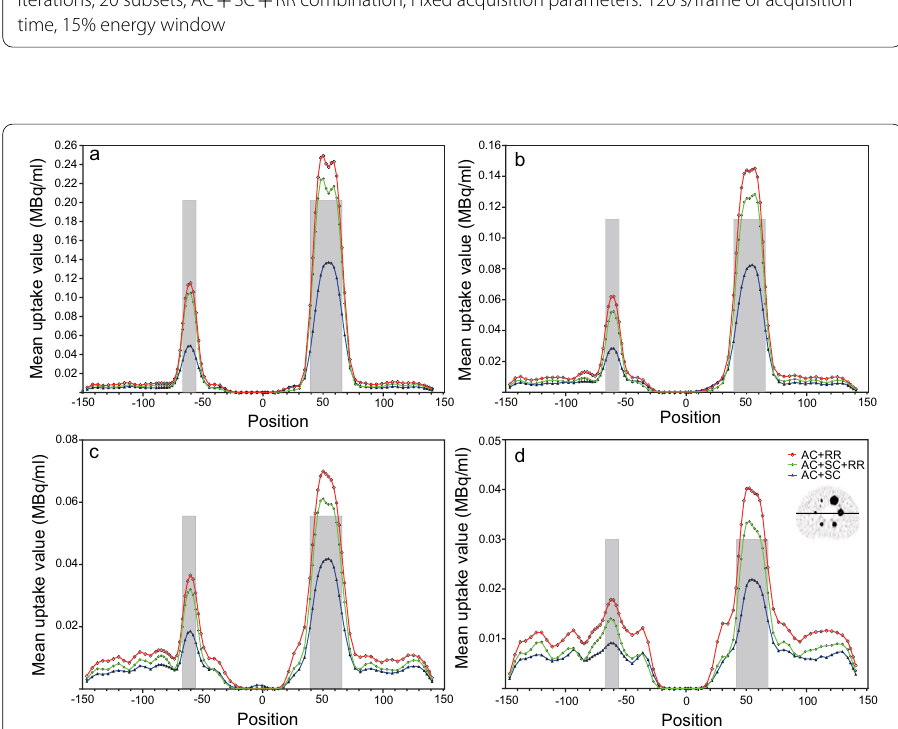
Fig. 5 Location of line profiles of 32:1 ( a ), 16:1 ( b ), 8:1 ( c ), and 4:1 ( d ) T/B ratios through the central slice of the entire phantom. X-axis indicates the pixel position of the phantom; Y-axis indicates the calculated mean uptake values of the phantom; The upper edges of both grey areas are the actual radioactivity concentration in spheres; Different curves were calculated mean uptake values by using different correction combinations (AC SC RR, AC SC, and AC RR); Fixed reconstruction parameters: 35 iterations, 20 subsets, no filter; + + + + Fixed acquisition parameters: 120 s/frame of acquisition time, 15% energy